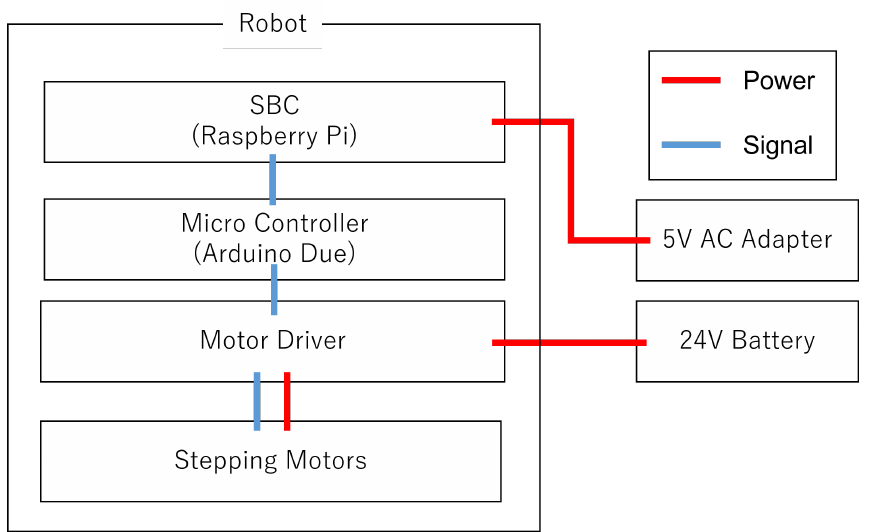
Figure 6. The robot hardware configuration.